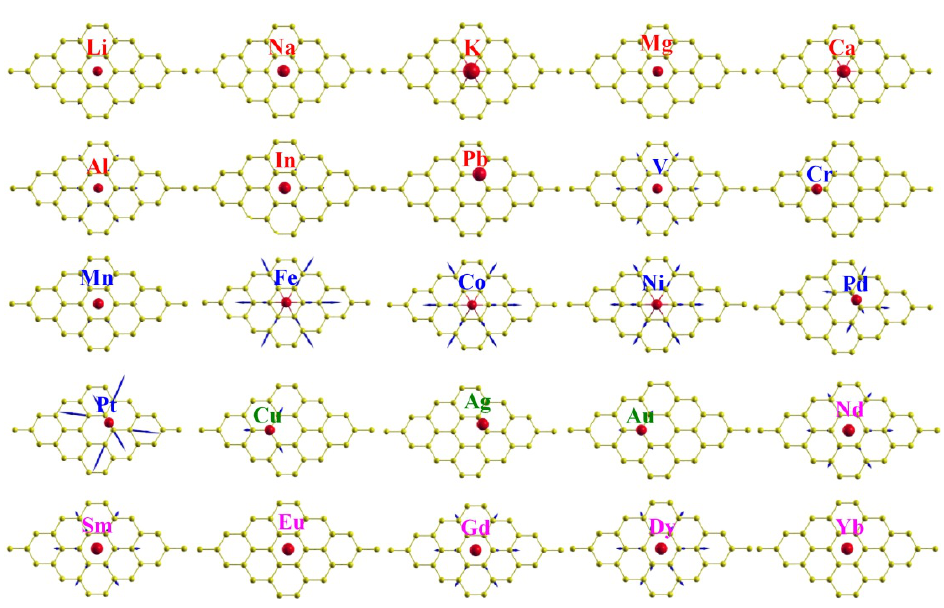
Figure 12. In-pane distortion of graphene lattice due to the adsorption of metal adatoms. The length of the arrows represents the amplitude of the distortion and the direction of the arrows represents the direction of the distortion. The displacements have been enlarged by a factor of 5000 for a clear